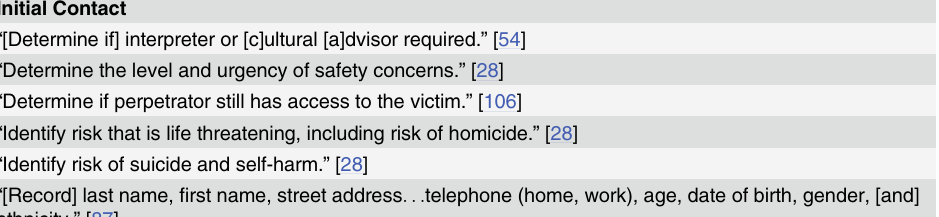
Table 4. Example Recommendations Relevant to a Comprehensive Hospital-based Intervention. Initial